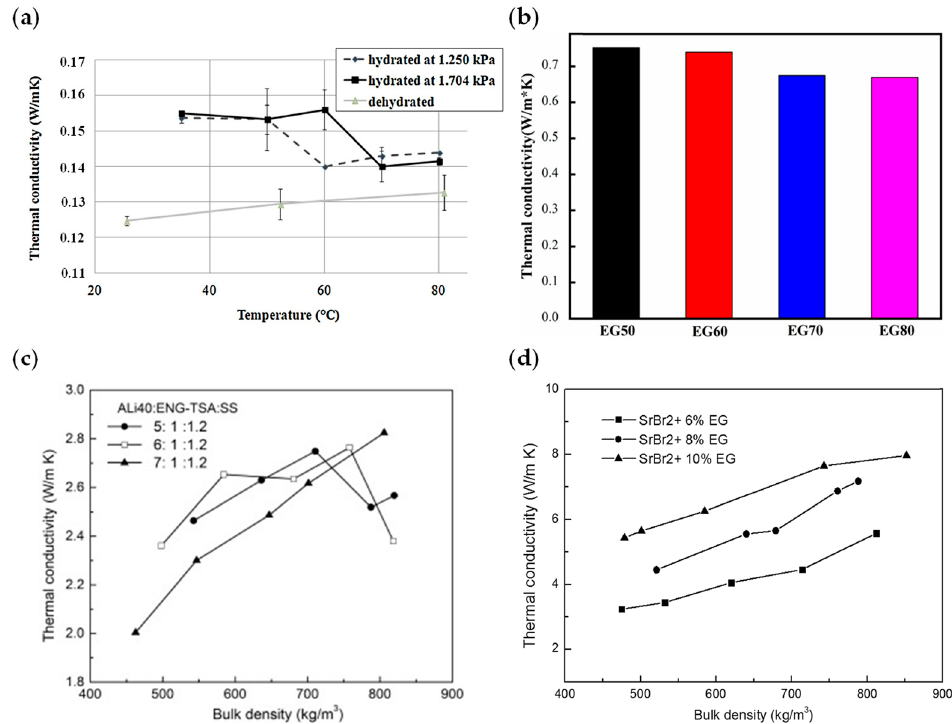
Figure 21. Thermal conductivity of composites: ( a ) silica gel-CaCl 2 [211], ( b ) expanded graphite-